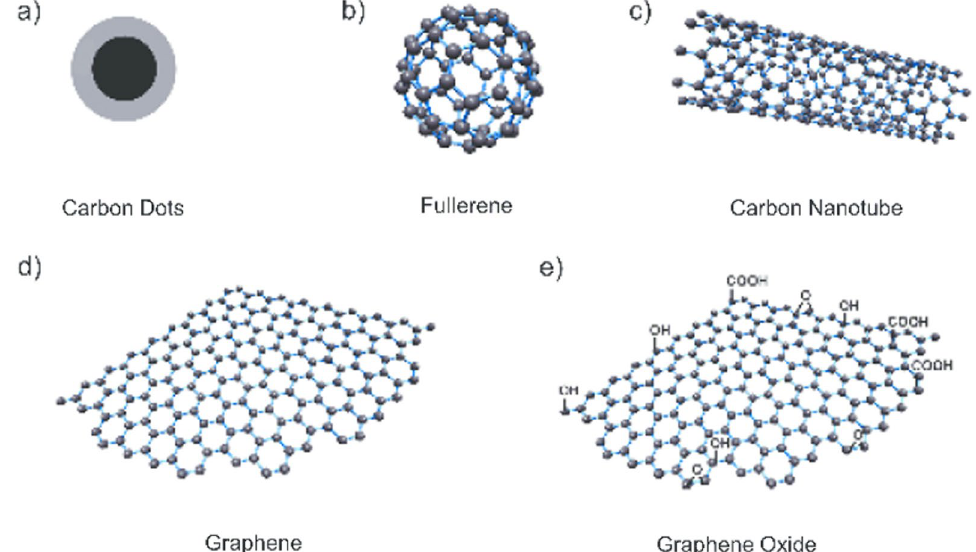
Fig. 4 Zero-dimensional carbon nanomaterials, a carbon dots, and b fullerene. One-dimensional carbon nanomaterial, c carbon nanotube. Two-dimensional carbon nanomaterial, d graphene, and e graphene oxide (Han et al.